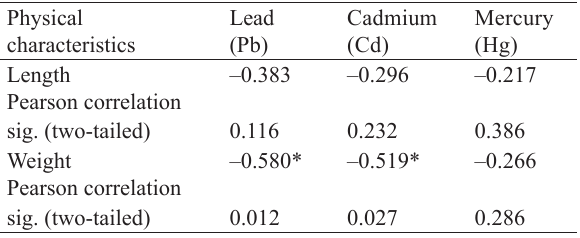
Table 5 Biomagnification factors of three metals Aquaculture